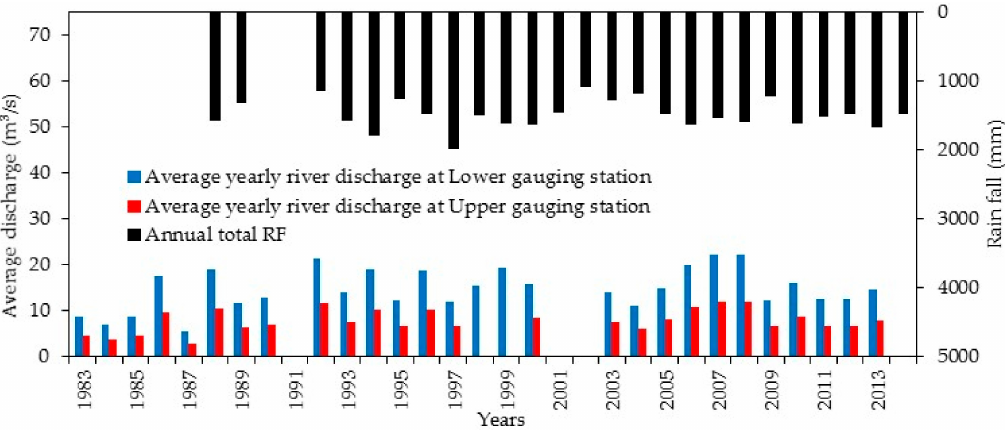
Figure 2. Yearly rainfall from the year 1988 to 2014 and average Ribb River discharges from the year 1983 to 2013 for the Lower and Upper gauging stations. The graph does not show any increasing or decreasing trends. Data source: National Meteorological Agency and Ministry of Water, Irrigation and Energy,